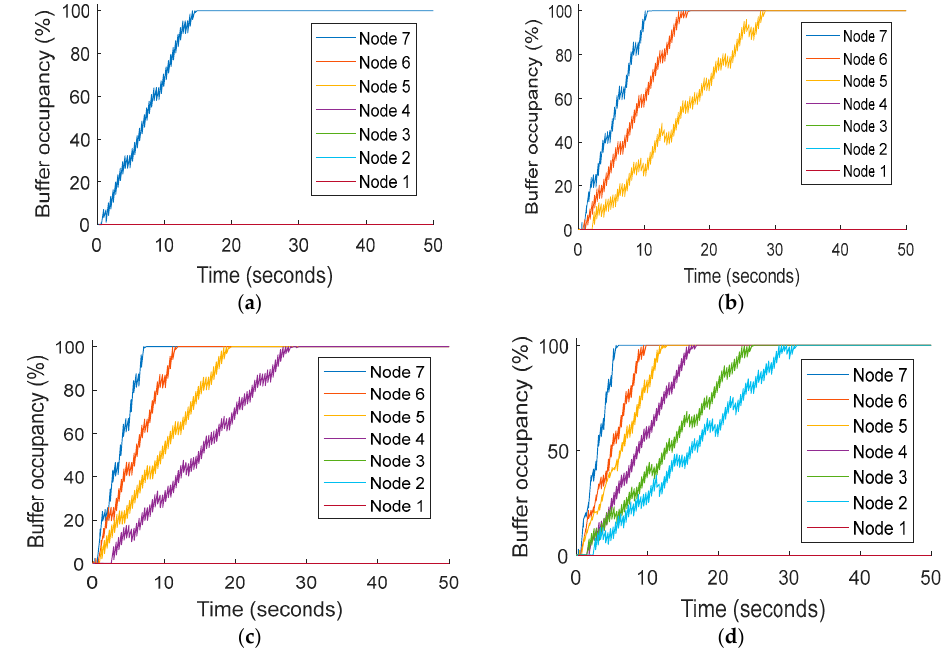
Figure 8. Buffer occupancy with NoIVSP for different data rates: ( a ) 0.1 Mbps; ( b ) 0.5 Mbps; ( c ) 1 Mbps; and ( d ) 2 Mbps.